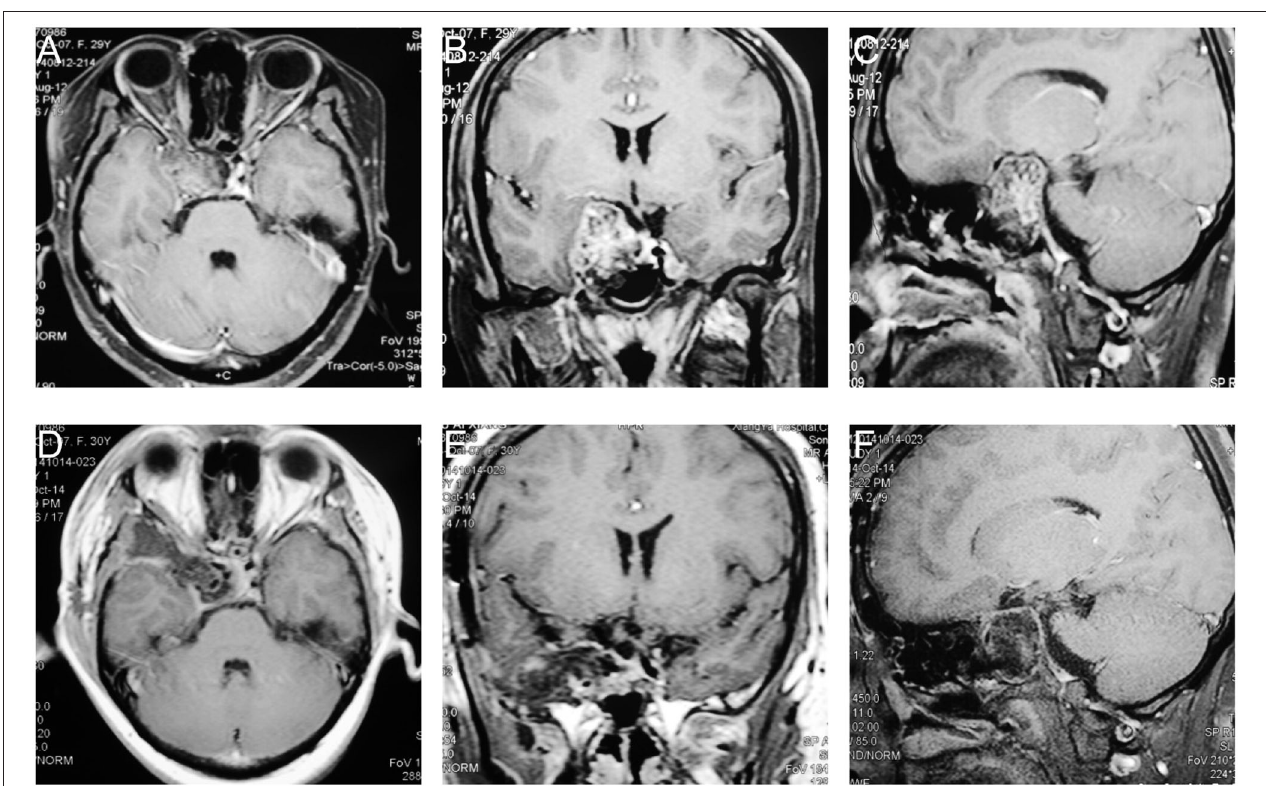
FIGURE 1 | The preoperative and postoperative MRI imaging of case 1. (A–C) Preoperative MRI showed the tumor involved intrasellar and the right CS. (D–F) Postoperative MRI showed the tumor was gross total resected.